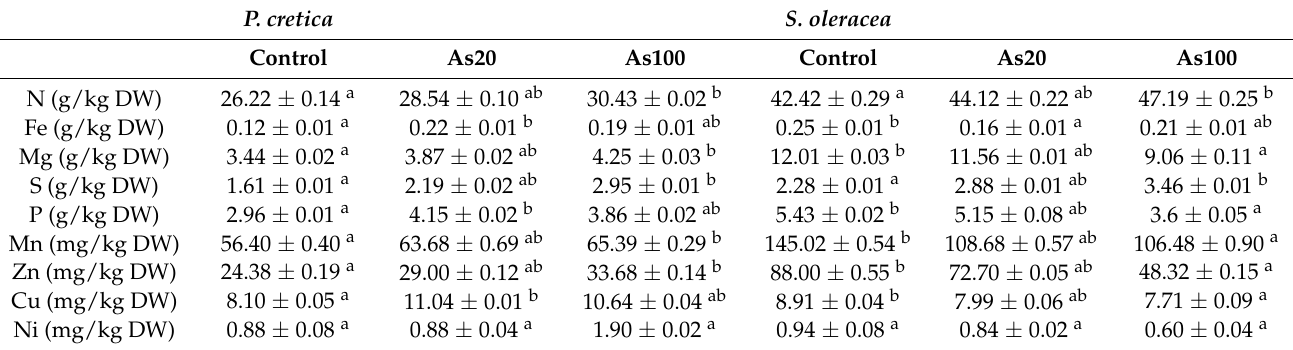
Table 2. Nutrient content in Pteris cretica and Spinacia oleracea shoots. Values represent the mean ± SE of three biological and two technical replicates per sample. Data with the same letter are not significantly different. Different letters indi- cate significant differences ( p ≤ 0.05) among treatments according to the Kruskal-Wallis test. Treatment